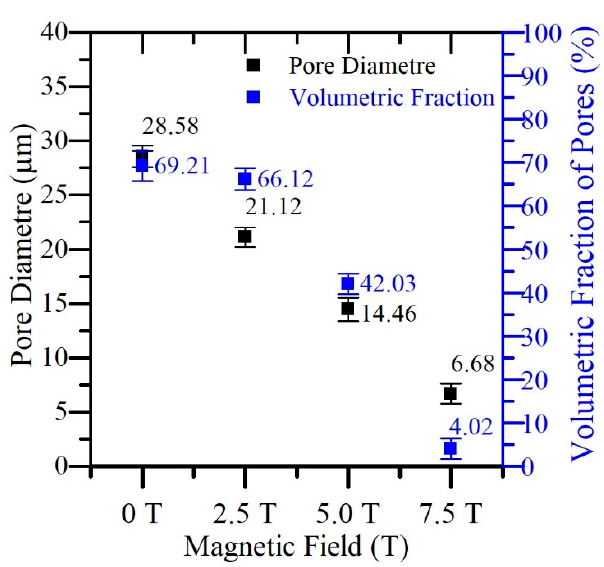
Figure 10. Study of the pore diameter and volumetric fraction of the microstructure after the Charpy